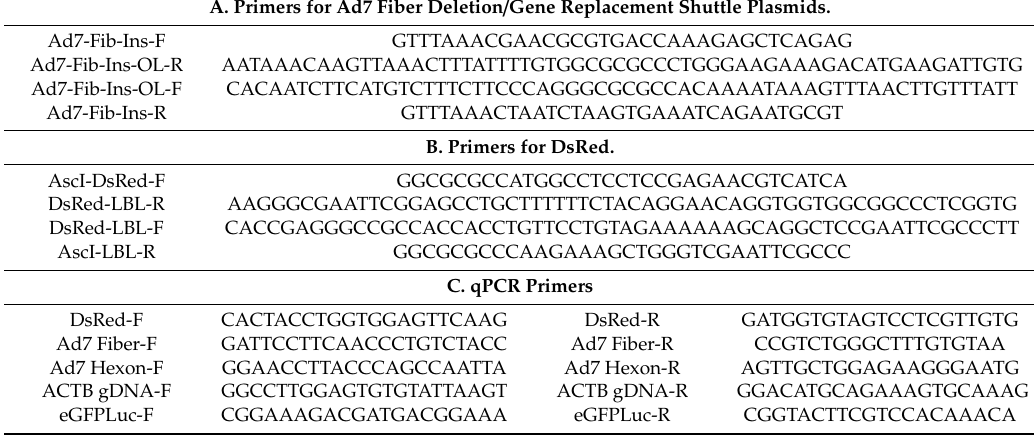
Table 1. Primers for the creation and testing of the scAd7 vaccine. These primers were used for the PCR amplification of the homologous flanking DNA used for inserting the DsRed gene in place of the fiber gene ( A ). Ad7-Fib-Ins-F and Ad7-Fib-Ins OL-R primer pairs were used to amplify the 500 bp region 5 (cid:48) of the fiber gene. Ad7-Fib-Ins-OL-F and Ad7-Fib-Ins-R primer pairs were used to amplify the 500 bp region 3 (cid:48)(cid:48) of the fiber gene. The two PCR products were combined, and the Ad7-Fib-Ins-F and Ad7-Fib-Ins-R primers were used to amplify the overlapping PCR products. These primers were used to create the DsRed floxed blasticidin gene for incorporation into the shuttle plasmid ( B ). The overlapping PCR products were amplified similar to the previously described the shuttle PCR product. The following PCR primer sets were used to quantitate the viral genes, cellular Actin gene, and the introduced DsRed and GFP-Luc genes ( C